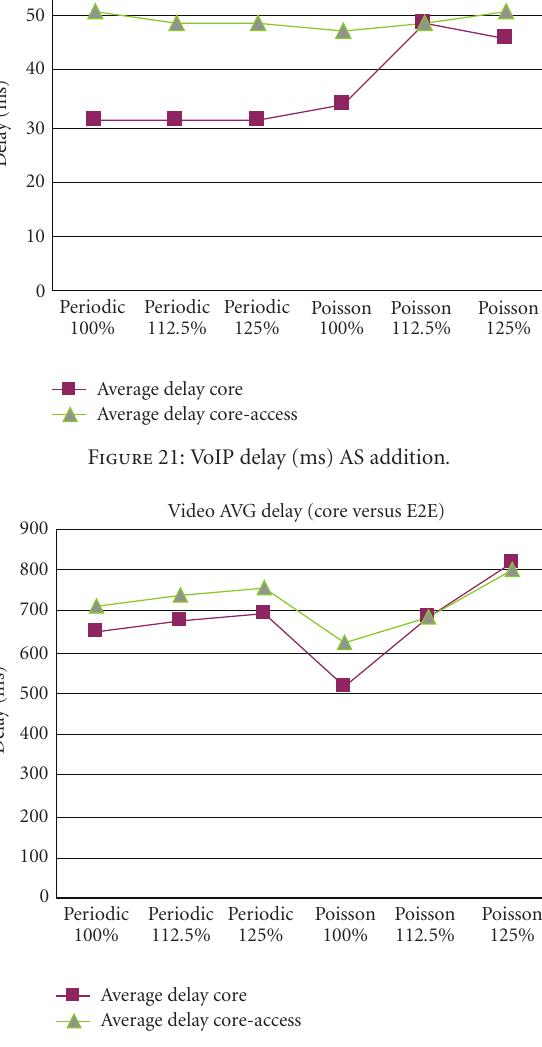
Figure 22: VoIP delay (ms) AS